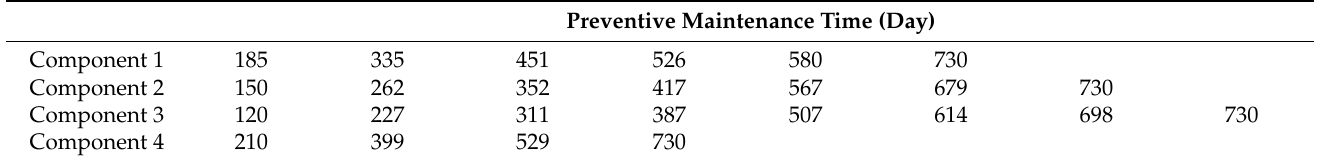
Table 6. Preventive maintenance times of each component (calendar time).